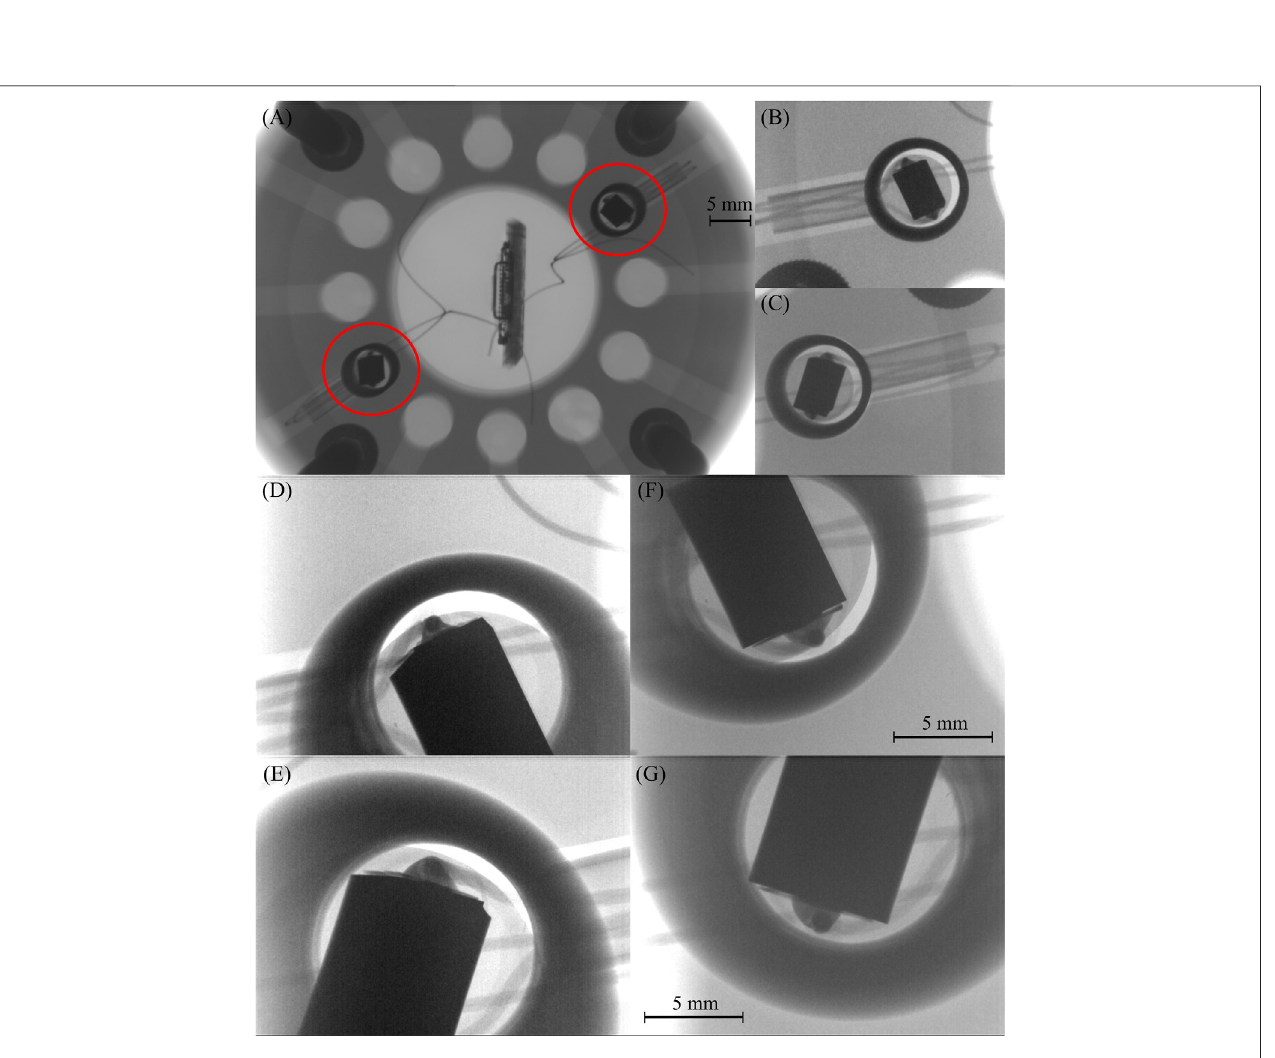
FIGURE 7 | High-resolution x-ray images showing wire-bonding for both actuators on Test article #1. (A) Top x-ray image of the canister. The red circles indicate the piezo actuator placements. (B, C) Close-up x-ray image of the piezo actuators. (D – G) Close-up images showing the wire bonding on each side of the piezo- element